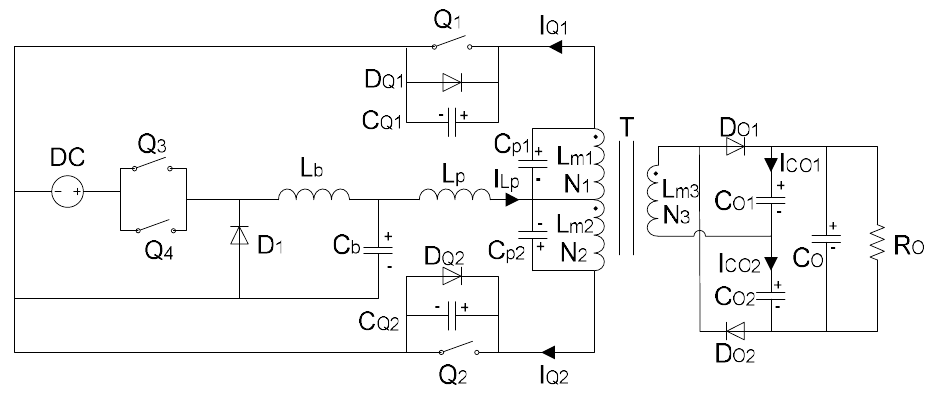
Figure 3. The DC/DC converter circuit diagram.